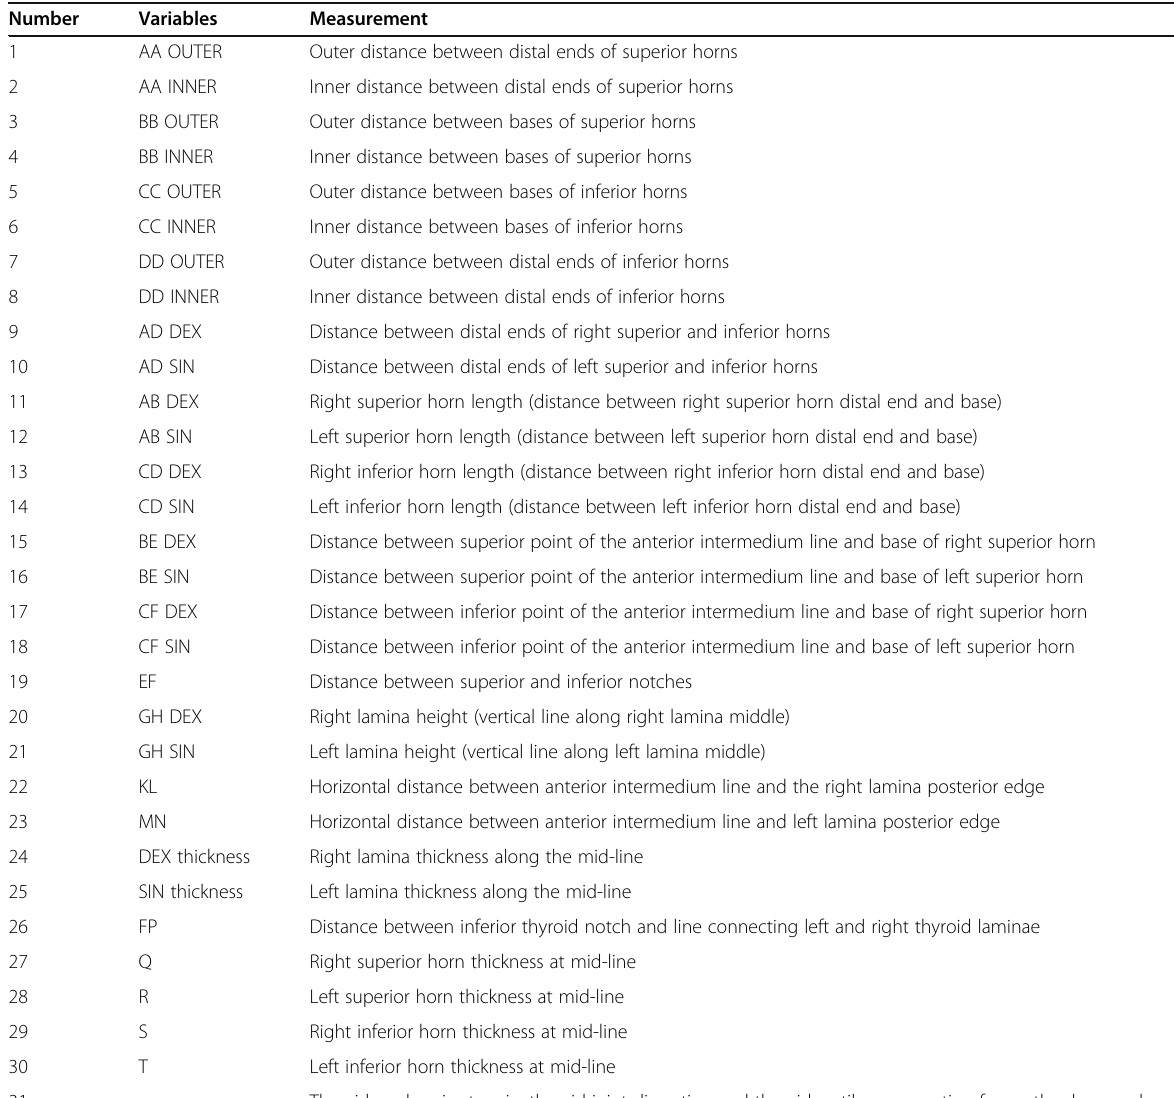
Table 2 Thyroid cartilage